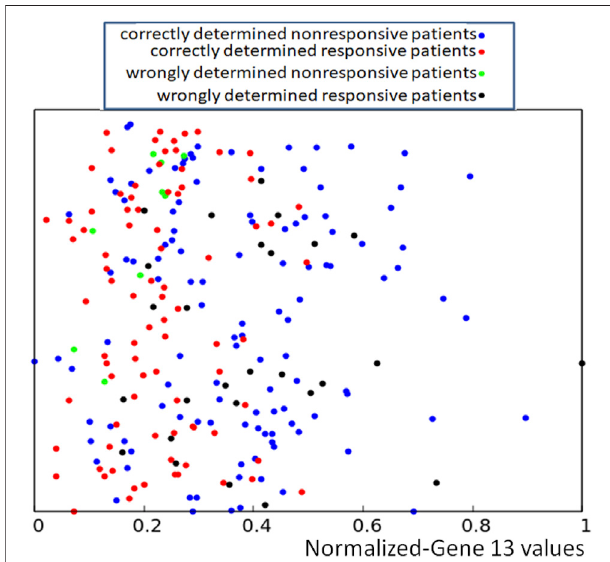
FIGURE7 | Location ofcorrect and incorrect predictionson theresult of drug therapy predicted by a concilium of networks of oscillators optimized for all genes. The values of p 13, k are represented by the x-coordinate of marked points. The y-coordinate is the same as in Figure 2 .